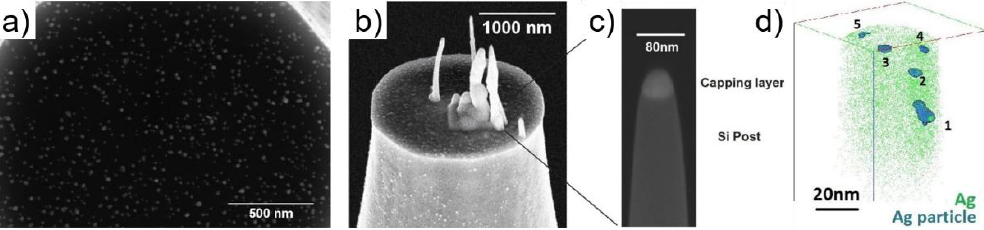
Figure 9. Study of Ag nanoparticles prepared by gas condensation process. ( a ) High density and clearly separated Ag nanoparticles on Si coupon; ( b ) e-beam deposition of Pt as embedding matrix; ( c ) final tip after FIB milling with nanoparticles embedded; and ( d ) 3D reconstruction showing the presence of isolated Ag nanoparticles and Ag atoms distributed throughout the tip-sample. Reprinted